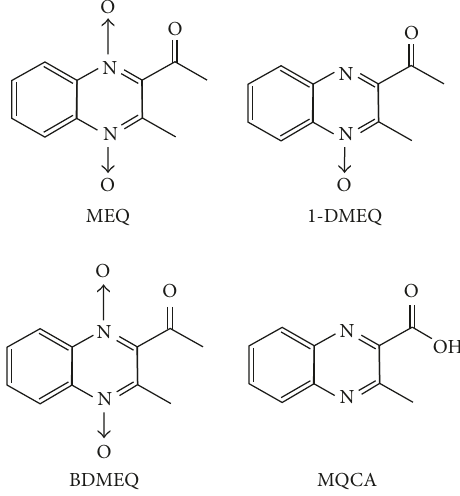
Figure 1: Chemical structures of 1-DMEQ, BDMEQ, MEQ, and